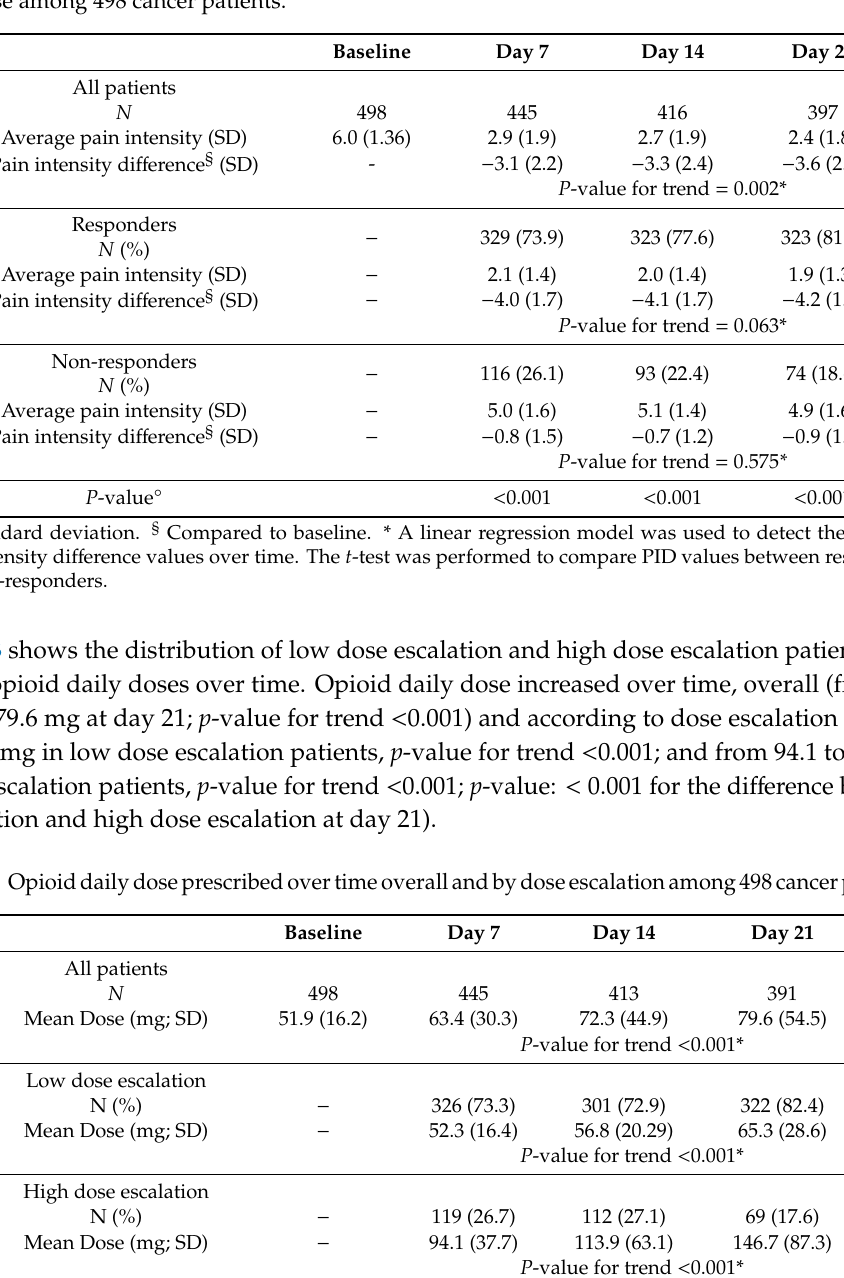
Table 2. Average pain intensity and pain intensity di ff erence over time overall and by analgesic response among 498 cancer patients.